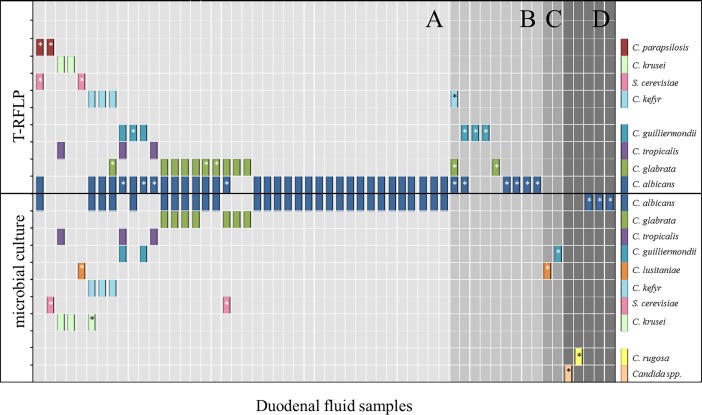
Fungal species analysis using either the T-RFLP or conventional culture methods on duodenal fluid samples from patients with liver cirrhosis and controls (n = 56).Each bar represents a single species. A star indicates that a fungal species could not be confirmed by the alternative method. The x-axis presents single duodenal samples so that multiple culture or T-RFLP-identified pathogens per sample are stacked in columns. Samples with culture-positive and PCR/T-RFLP-positive samples are compared in A (n = 40). Culture-negative but PCR/T-RFLP-positive samples are displayed in B (n = 9) and culture-positive and PCR/T-RFLP-negative samples are presented in C (n = 2). The duodenal samples that were culture-positive and PCR-positive but T-RFLP-negative are represented in area D (n = 5). Additional duodenal samples that were culture negative but PCR-positive with DNA not being sufficient for T-RFLP analysis (n = 3) have been left out in analysis.